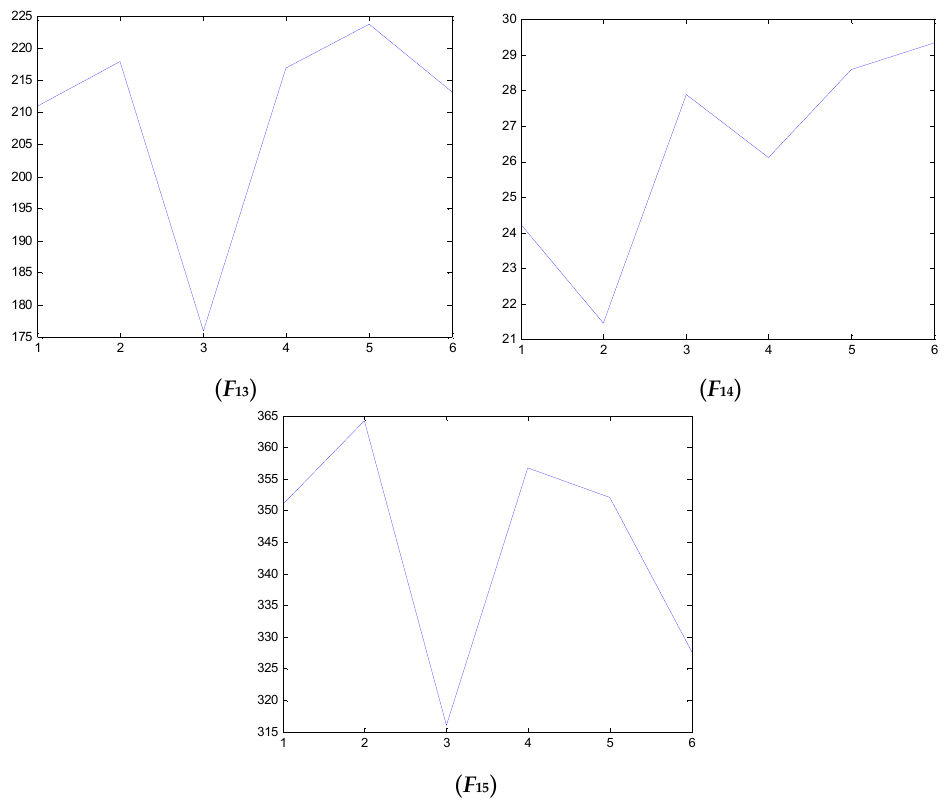
Figure 18. The analyzed results of A fan No. 2H sensor by F 13 , F 14 and F 15 .